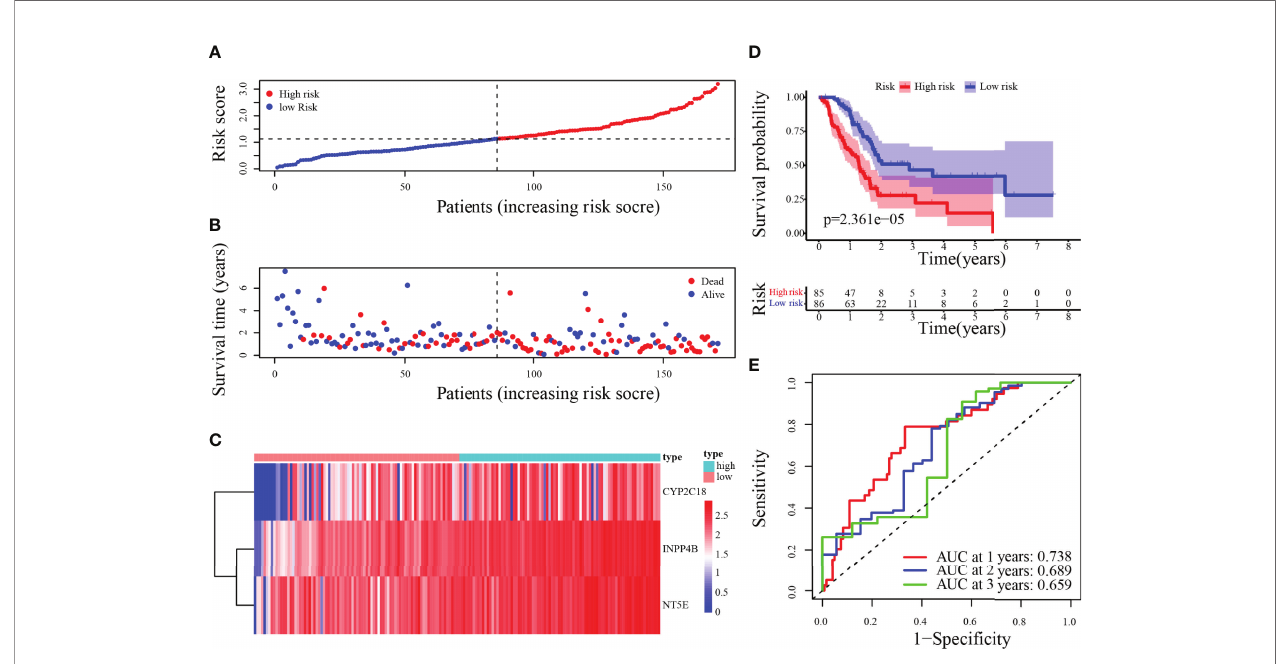
FIGURE 5 | Risk score analysis of the 3-MRG prognostic model in the training cohort. (A – D) The risk curve, survival status of PC patients, heatmap of the 3-MRG expression, and survival curves between lower and higher-risk groups are shown. (E) Time-independent ROC curves of the risk score for predicting the OS in the training cohort.